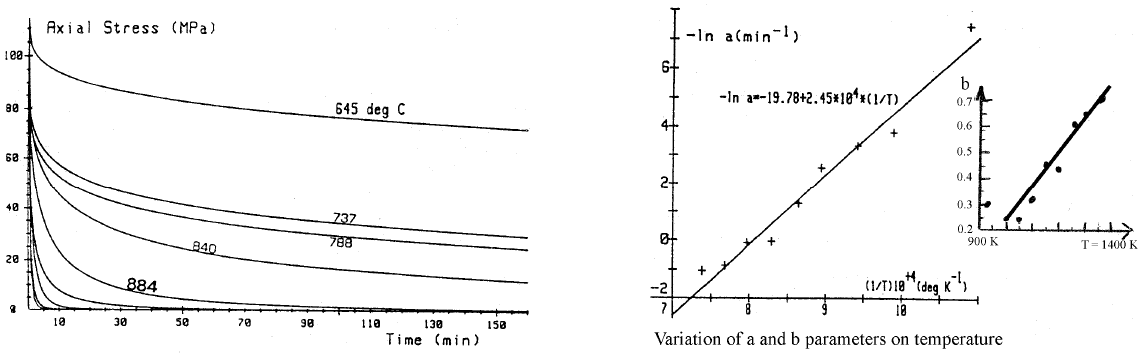
Figure 14. Stress relaxation in Ge-doped fibers, reprinted with permission from